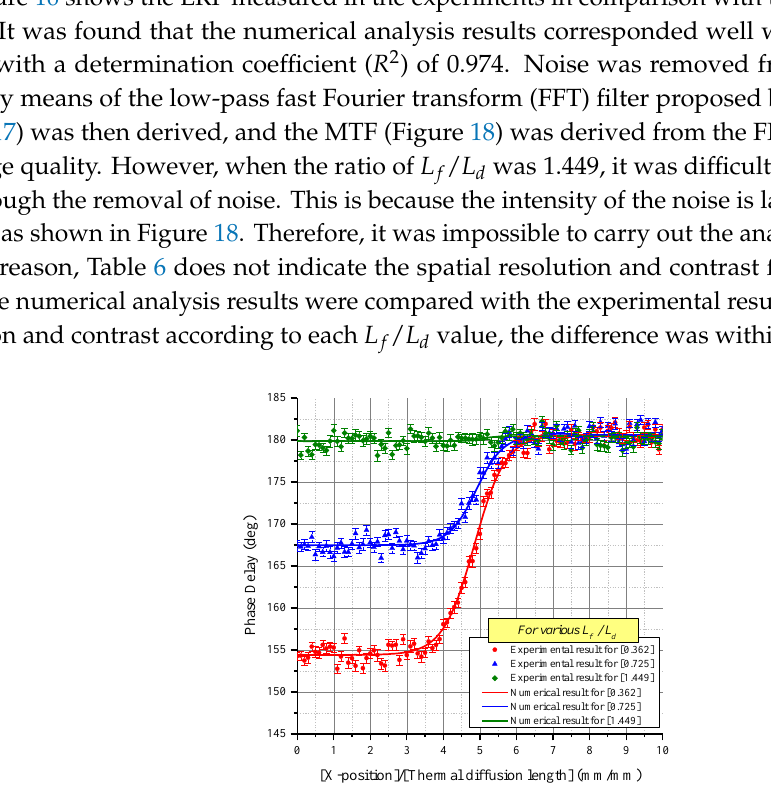
Figure 16. ERF comparison between the experimental and numerical analysis results.